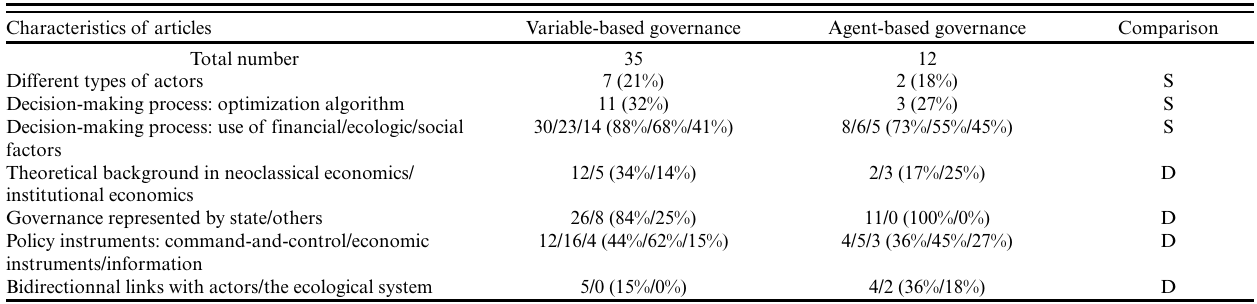
Table 2 . Number of articles for each characteristic and in parentheses the percentage of the total per form of governance implemented. Comparison between forms of implementation: similarities (S) and differences (D). Numbers do not necessarily add up to 45 or 100% because 1 article may use several categories at the same time or because an assessment was not possible for some